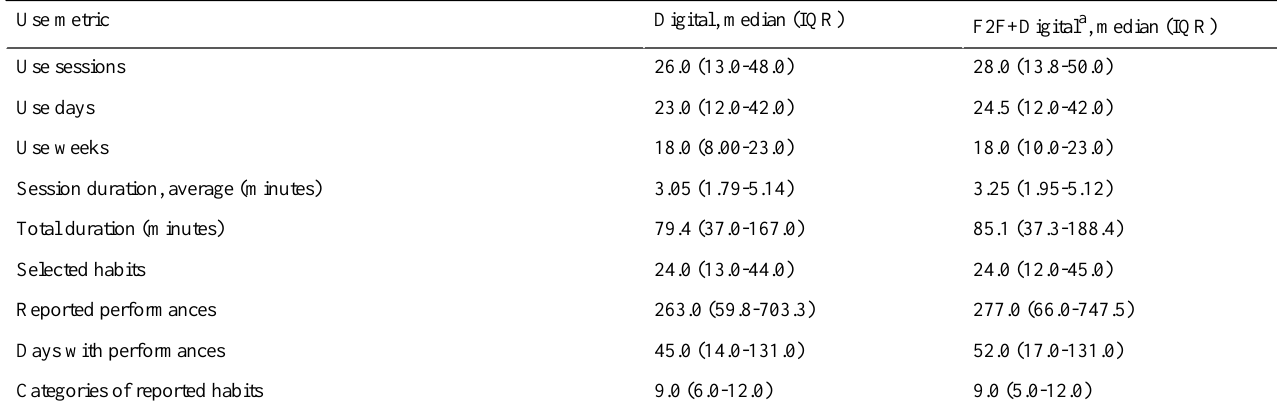
Table 2. Cumulative use metrics for the first 6